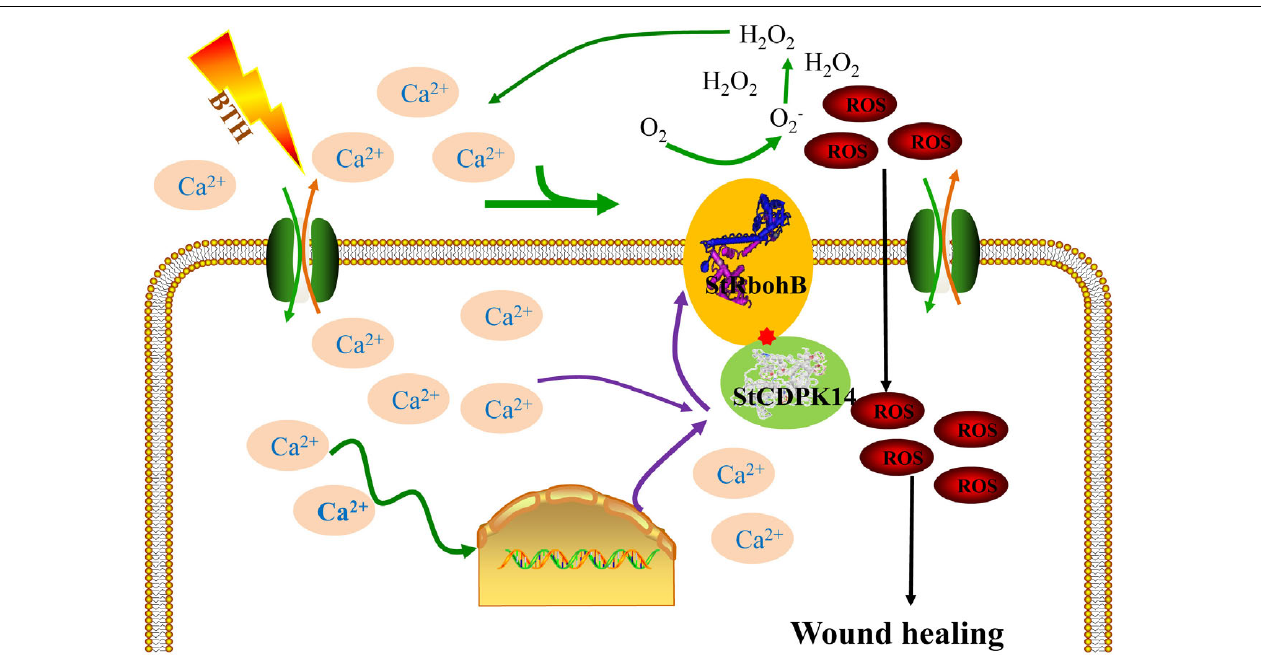
FIGURE 10 | Integration of regulatory mechanisms of StCDPK14 involving in the wound healing of potato tubers treated with BTH. Proposed regulations are shown in the scheme as discussed in this article. The elicitor BTH induced the Ca 2 + influx in the cytosol and triggers the relaying of Ca 2 + signal in cells. Once the Ca 2 + signal generated, CDPK (Ca 2 + sensor) activity was activated by Ca 2 + binding to EF-hand domain. Subsequently, the downstream RbohB activity was activated via interacting with CDPK and produced reactive oxygen species (ROS), which was tied to the wound healing as a signal molecule and oxidative cross-linking the precursors of healing